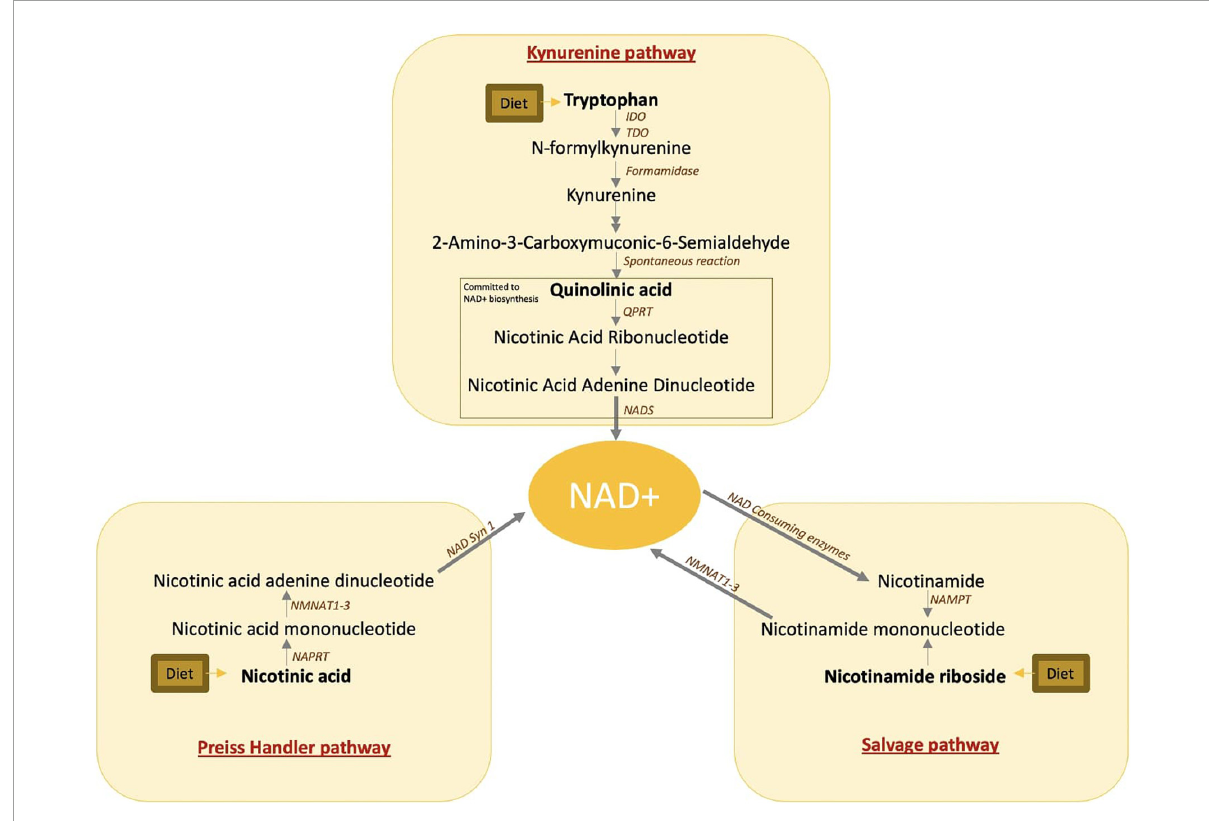
FIGURE1 NAD+ biosynthetic pathways. IDO, indoleamine-pyrrole 2,3-dioxygenase; TDO, tryptophan 2,3-dioxygenase; QPRT, quinolinate phosphoribosyltransferase; NAD, nicotinamide adenine dinucleotide; NADS, nicotinamide adenine dinucleotide synthetase 1; NMNAT, nicotinamide mononucleotide adenylyl transferase; NAPRT, nicotinate phosphoribosyltransferase; NAMPT, nicotinamide